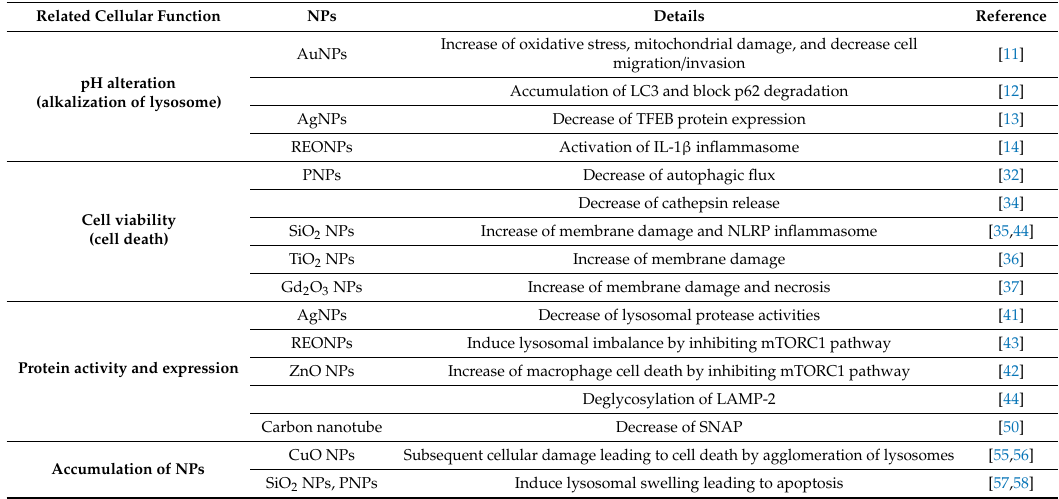
Table 2. The e ff ect of nanoparticles (NPs) on cellular